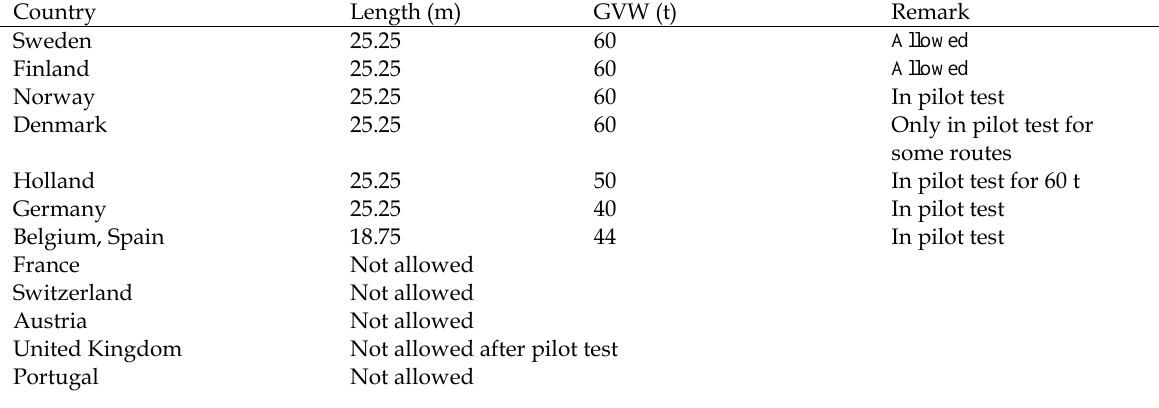
Table 4. Impacts of the use of larger trucks Country and